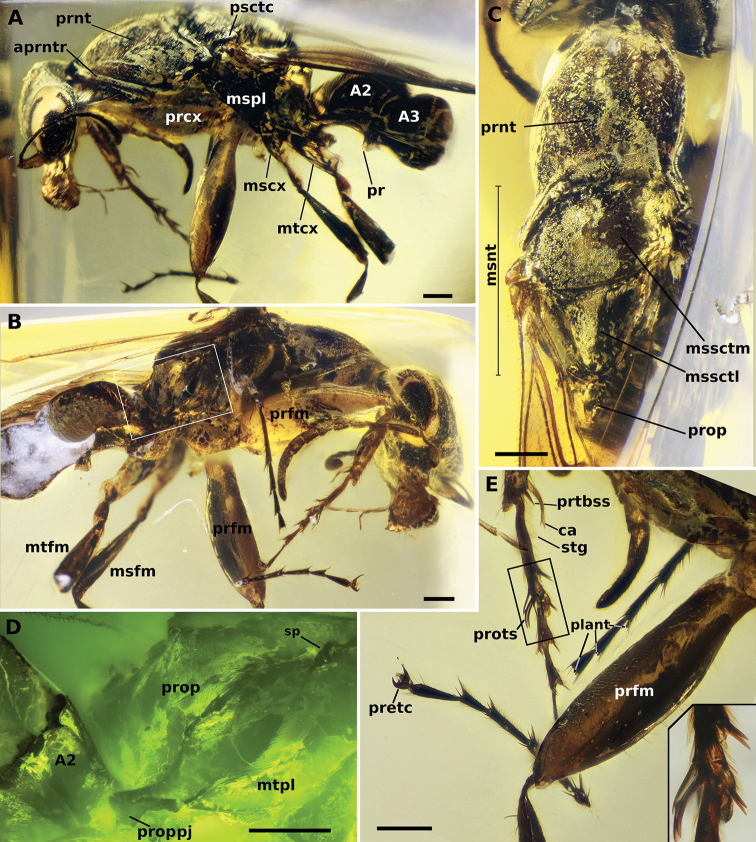
Holotype of †Camelosphecia
fossor sp. nov. A profile of left side of body B profile of right side of body C dorsal view of mesosoma D delimited area of C under fluorescent light E details of the legs, especially the forelegs. Abbreviations: A2–A3; abdominal segments 2 and 3; aprntr, anterior pronotal rim; ca, calcar; mscx, mesocoxa; msfm, mesofemur; msnt, mesonotum; mspl, mesopleural region of mesopectus; mssctm, mesoscutum; mssctl, mesoscutellum; mtcx, metacoxa; mtfm, metafemur; mtpl, metapleural region of metapectus; plant, plantulae; pr, prora; prcx, procoxa; pretc, pretarsal claws; prfm, profemur; prnt, pronotum; prop, propodeum; proppj, propodeal projection; prots, protarsomeres I and II chaetae; prtbss, distal protibia stout chaeta; psctc, parascutal carina; sp, propodeal spiracle; strg, strigil. Scale bars: 0.2 mm.